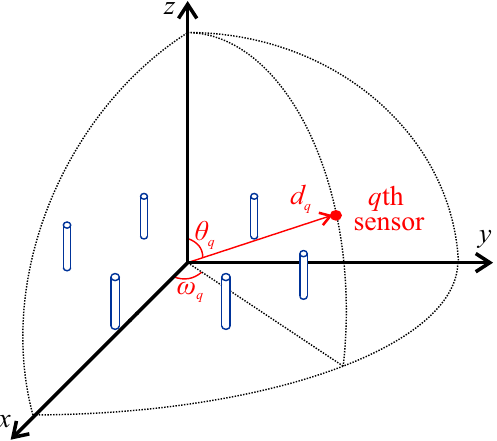
Figure 1. Representation of the angular position of the q th sensor around the array of antennas. The matrix VVV = [ vvv T